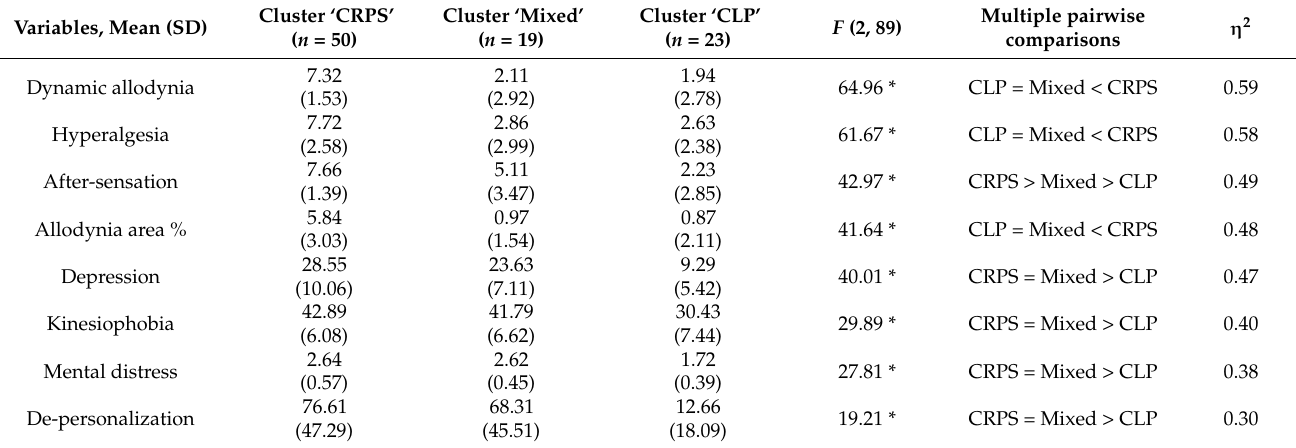
Table 3. Differences in the intensities of the measures between the cluster groups.